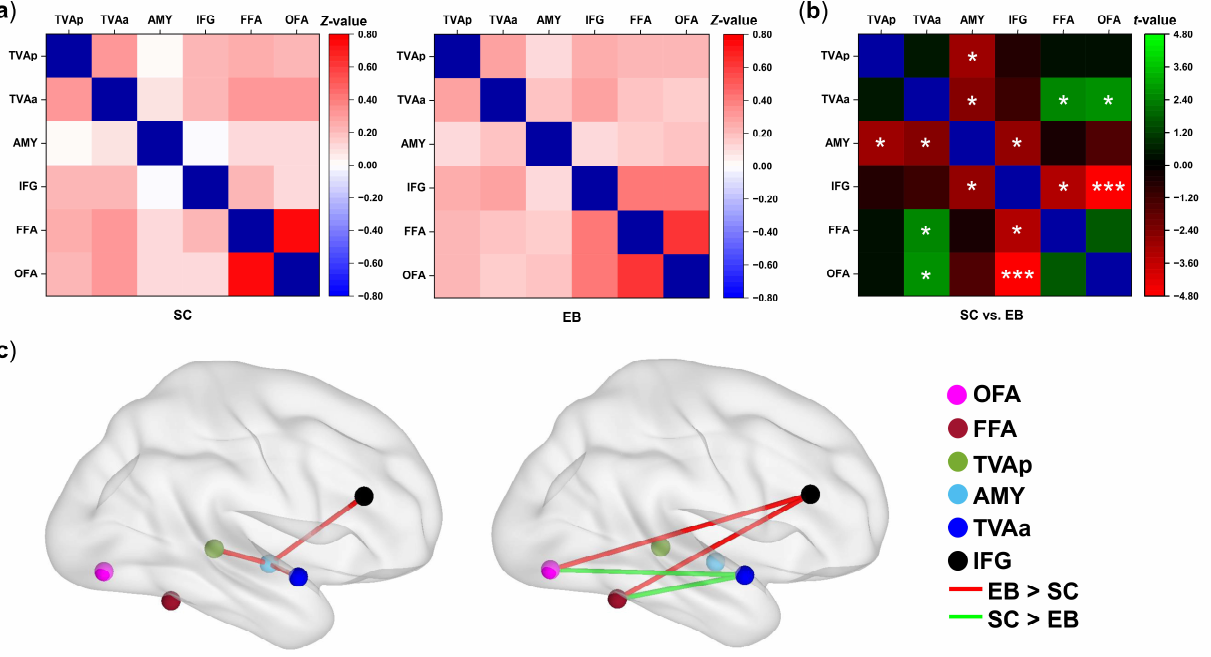
Figure 3. The between-group difference in the seed-based FCs. ( a ) Connectivity matrix reporting average FC between 6 ROIs of the sighted (SC) and blind (EB) participants. The color bar represents the Fisher z -scores of FCs. ( b ) The color bar represents the t -values for the contrast (SC vs. EB). Significance indicated by * ( p -FDR < 0.05) and *** ( p -FDR < 0.001). ( c ) The sagittal views show the significant differences in ROI-to-ROI FCs between the sighted and blind participants. Left panel: Changes of FCs within voice-sensitive areas; Right panel: Changes of FCs between the voice- and face-sensitive areas. Abbreviations: FFA, fusiform face area; OFA, occipital face area; TVAp, posterior “temporal voice areas”; AMY, amygdala; TVAa, anterior “temporal voice areas”; IFG, inferior frontal gyrus. Red lines represent enhanced connectivity in the blind (EB > SC); Green lines represent decreased connectivity in the blind (SC > EB).